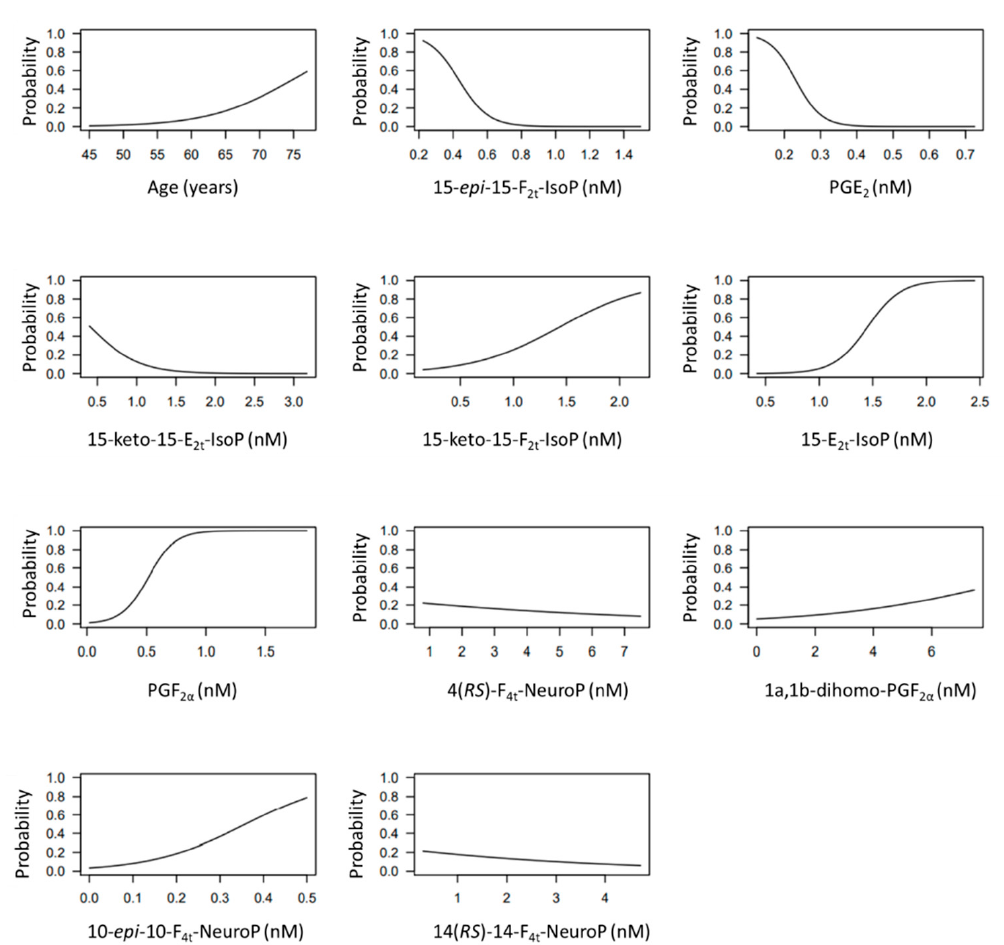
Figure 3. Conditional effect plots for each variable included in the model to predict the probability of preclinical-AD.